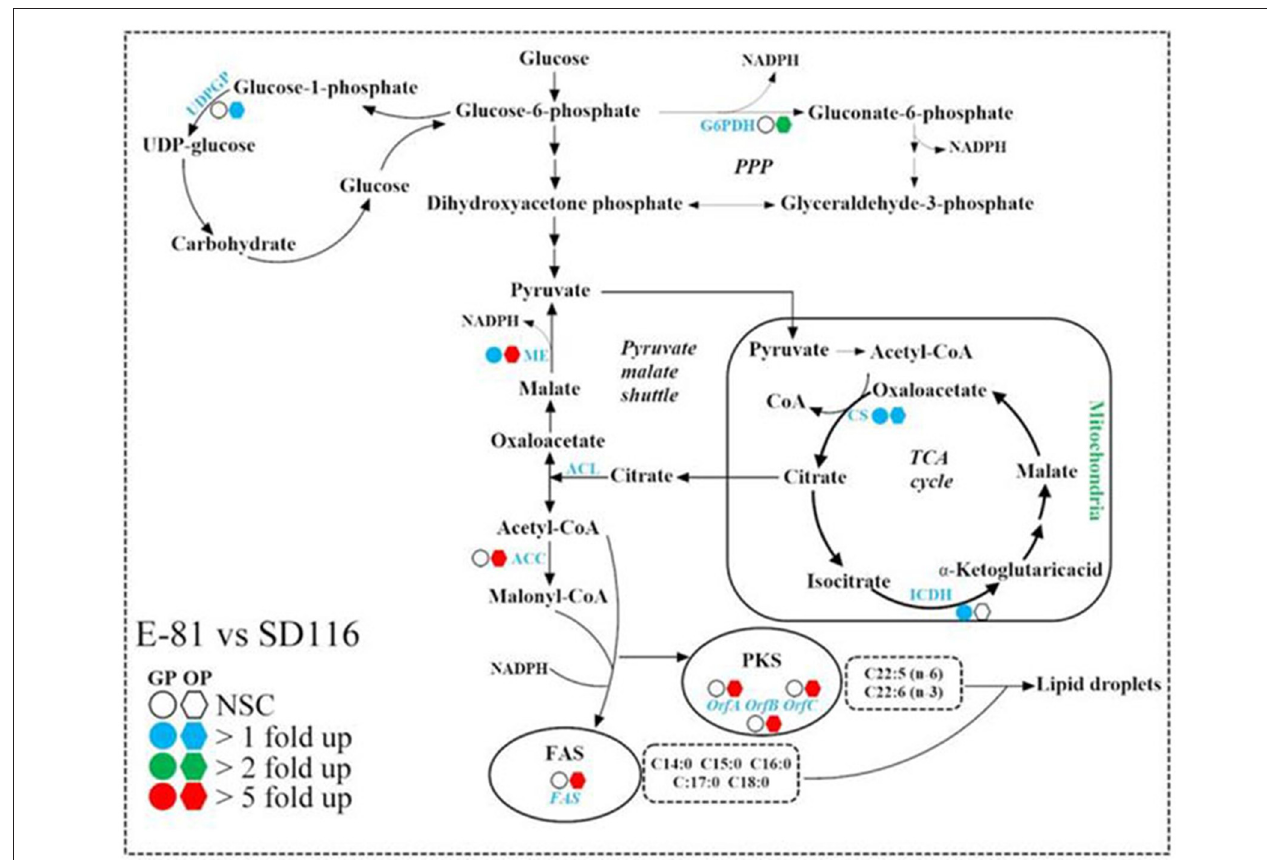
FIGURE 4 | Comparison of the transcription levels of key enzymes in fatty acid synthesis pathways of SD116 and E-81 strain. G6PDH, glucose-6-phosphate dehydrogenase; ME, malic enzyme; CS, citrate synthase; ICDH, isocitrate dehydrogenase; ACL, ATP citrate lyase; ACC, acetyl-CoA carboxylase; FAS, fatty acid synthase; PKS, polyketide-like polyunsaturated fatty acid synthase; OrfA, PKS subunit A; OrfB, PKS subunit B; OrfC, PKS subunit C; UDPGP, UDP-glucose pyrophosphorylase; NSC, no significant change; GP, growth phase; OP, oleaginous phase.